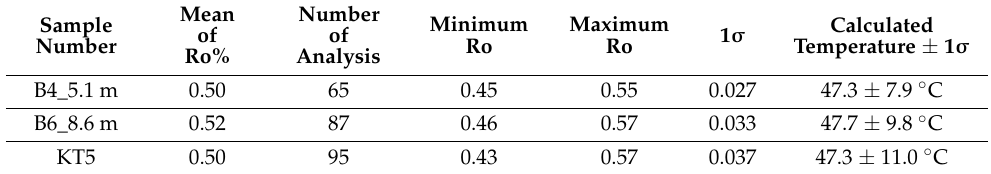
Table 4. Results of vitrinite reflectance analyses and calculated temperatures for coal layer samples from the boreholes (B4_5.1 m and B6_8.6 m) and outcrop sample (KT5) of the Shakubetsu Formation. See Figures 1b, 2a and 3 for the localities of analyzed coal layers. σ is one standard